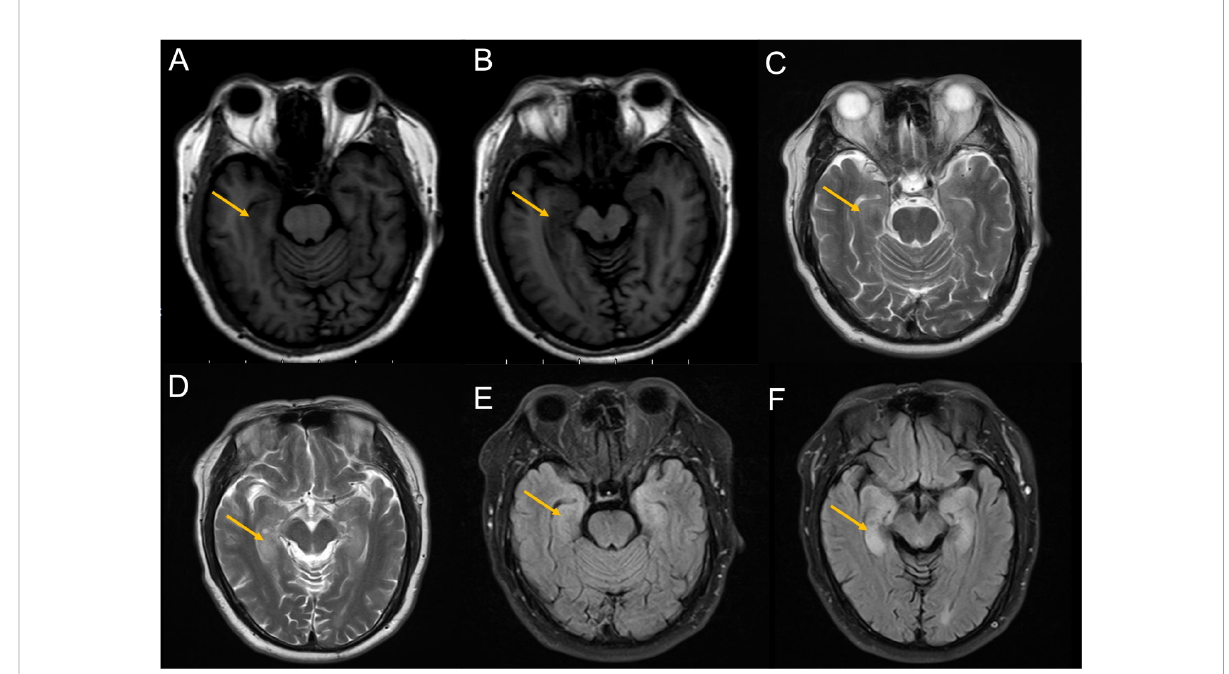
FIGURE 2 Images from the MRI after the second admission. (A, B) T1-weighted sequences showed slight hypointensity in the hippocampus (yellow arrow). (C, D) T2-weighted sequences showed hyperintensity in the hippocampus (yellow arrow). (E, F) FLAIR showed hyperintensity in the hippocampus (yellow arrow). magnetic resonance imaging; FLAIR, fl uid-attenuated inversion